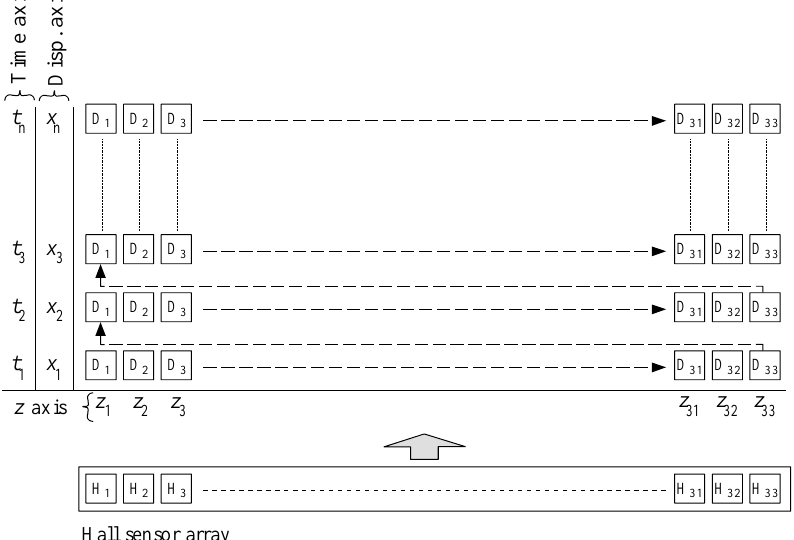
Figure 6. Data arrangement and construction in the Mobile Hall Sensor